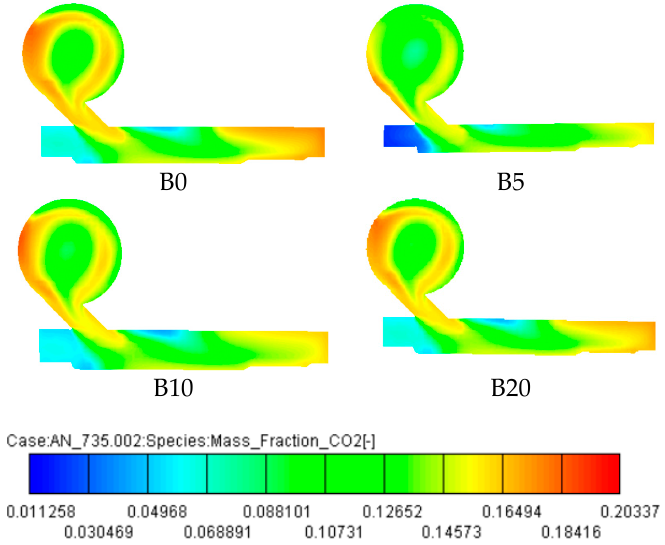
◦ ATDC at 1400 rpm and 100% 2 at 30